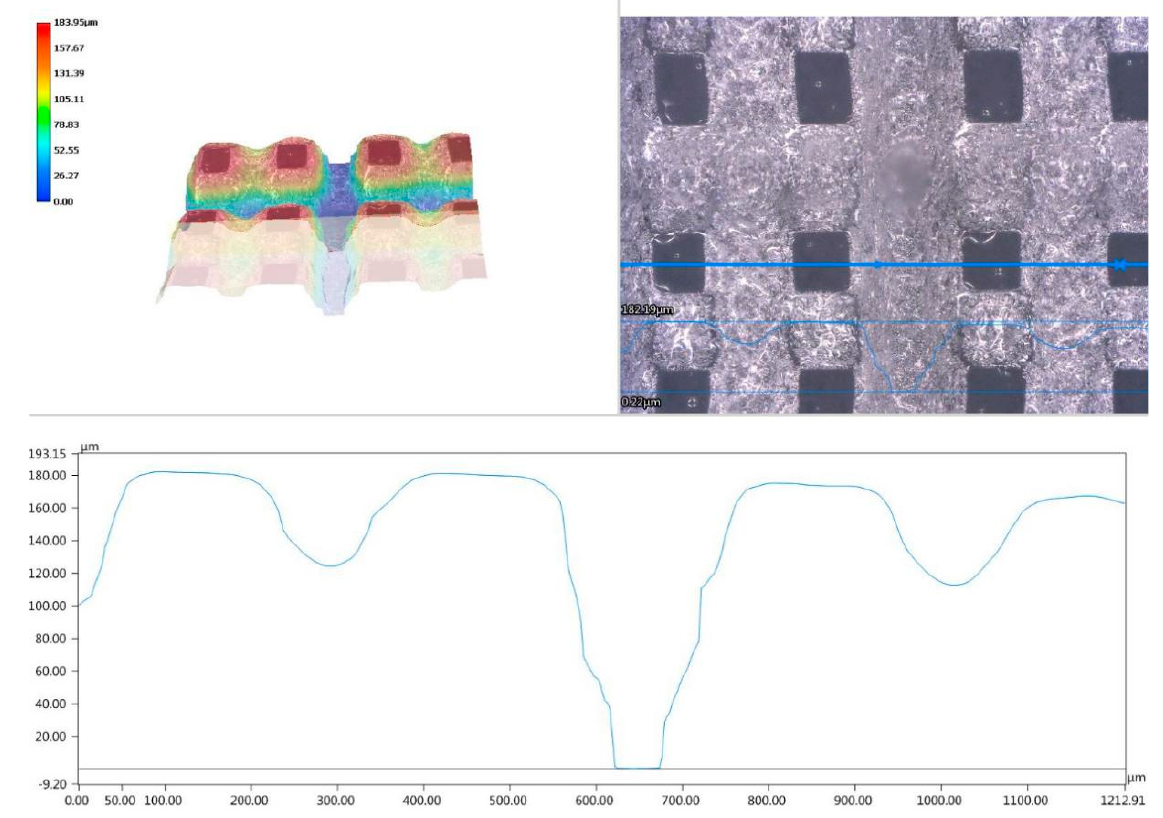
Figure 18. Three-dimensional morphology of cruciform secondary microstructure on PMMA surface.